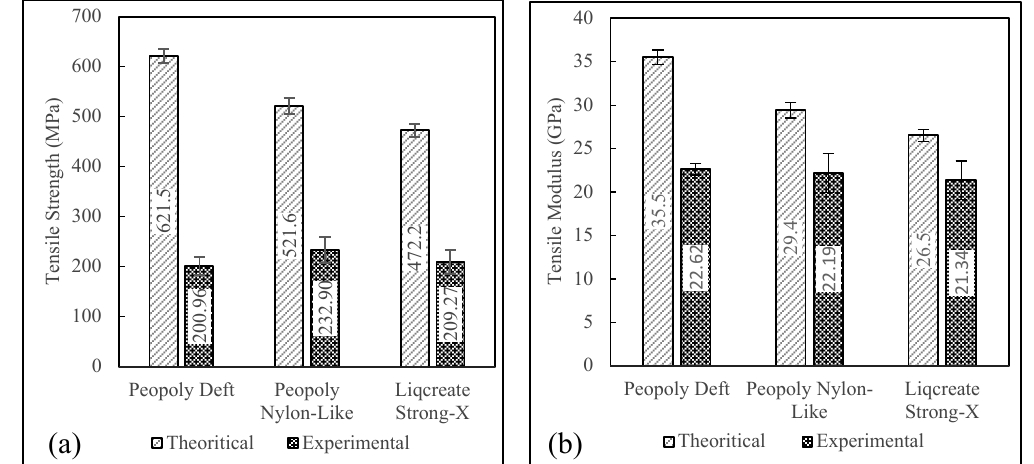
Figure 9. ( a ) Theoretical vs. experimental tensile modulus and ( b ) theoretical vs. experimental tensile strength.